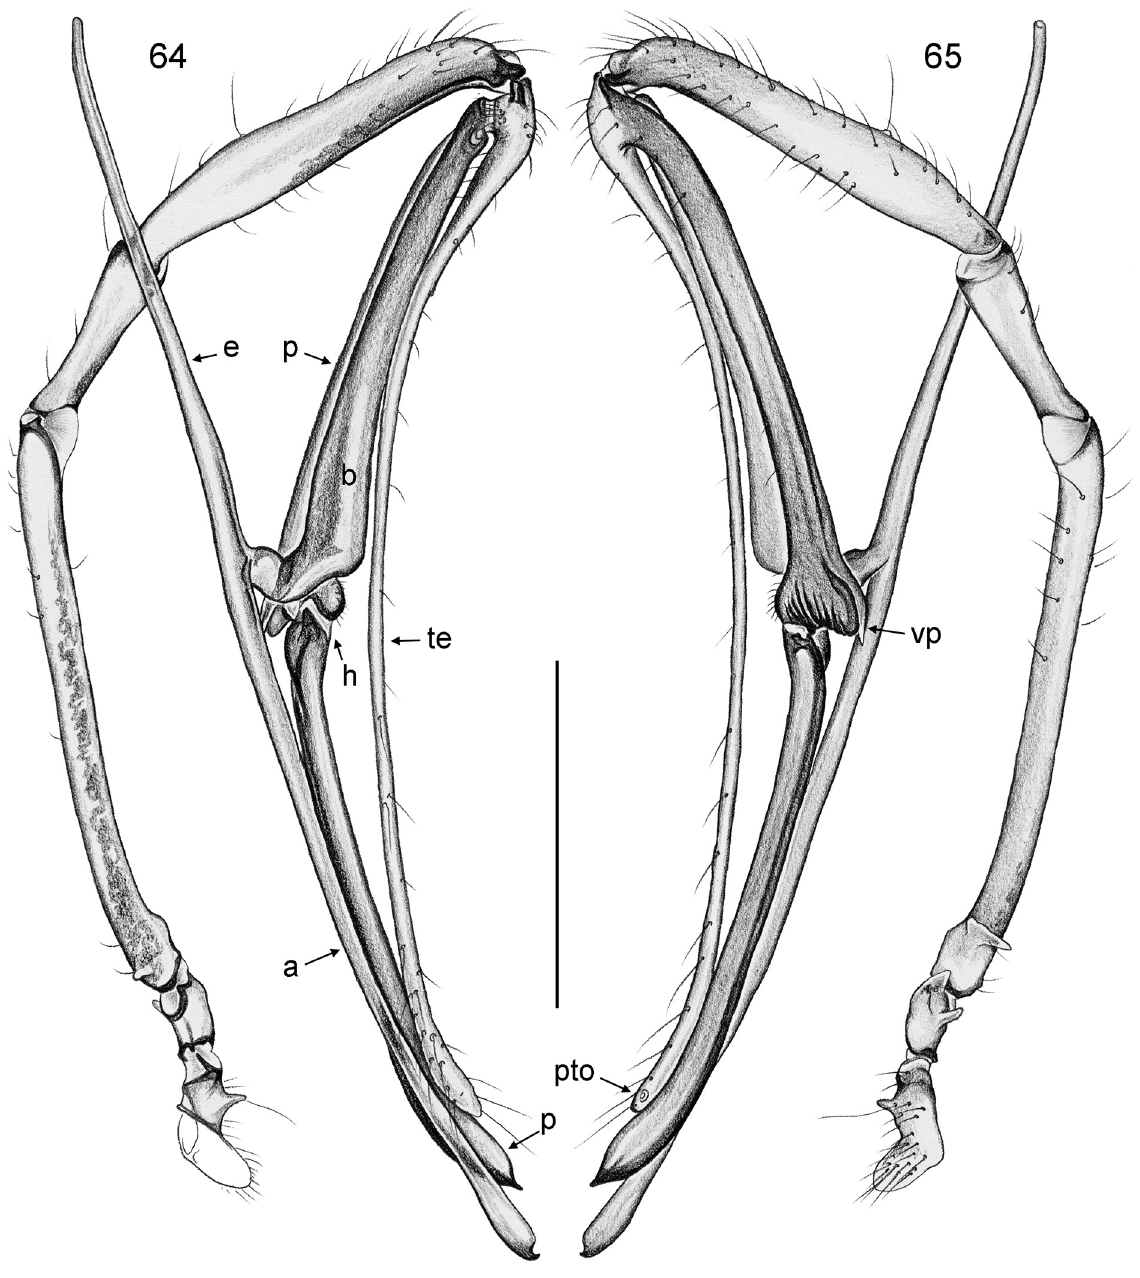
Figs 64–65. Panjange hamiguitan Huber sp. nov. (ZFMK, Ar 13009), left male palp, prolateral and retrolateral views. Abbreviations: a = appendix; b = genital bulb; e = embolus; h = hinge; p = procursus; pto = palpal tarsal organ; te = tarsal elongation; vp = ventral process. Scale bar = 1